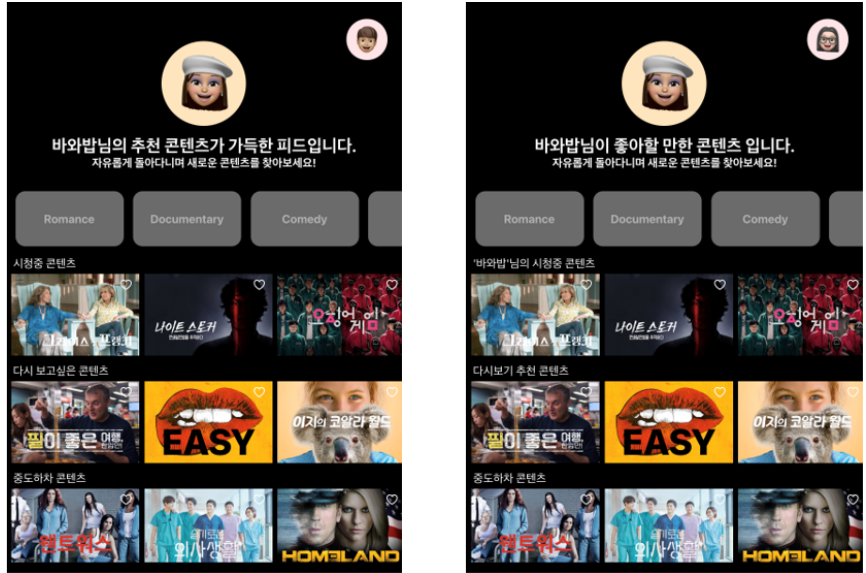
Figure 4. Stimuli representing both recommendation lists made by human ( left , “Content X would like to recommend”) and algorithm ( right , “Content X may like”).